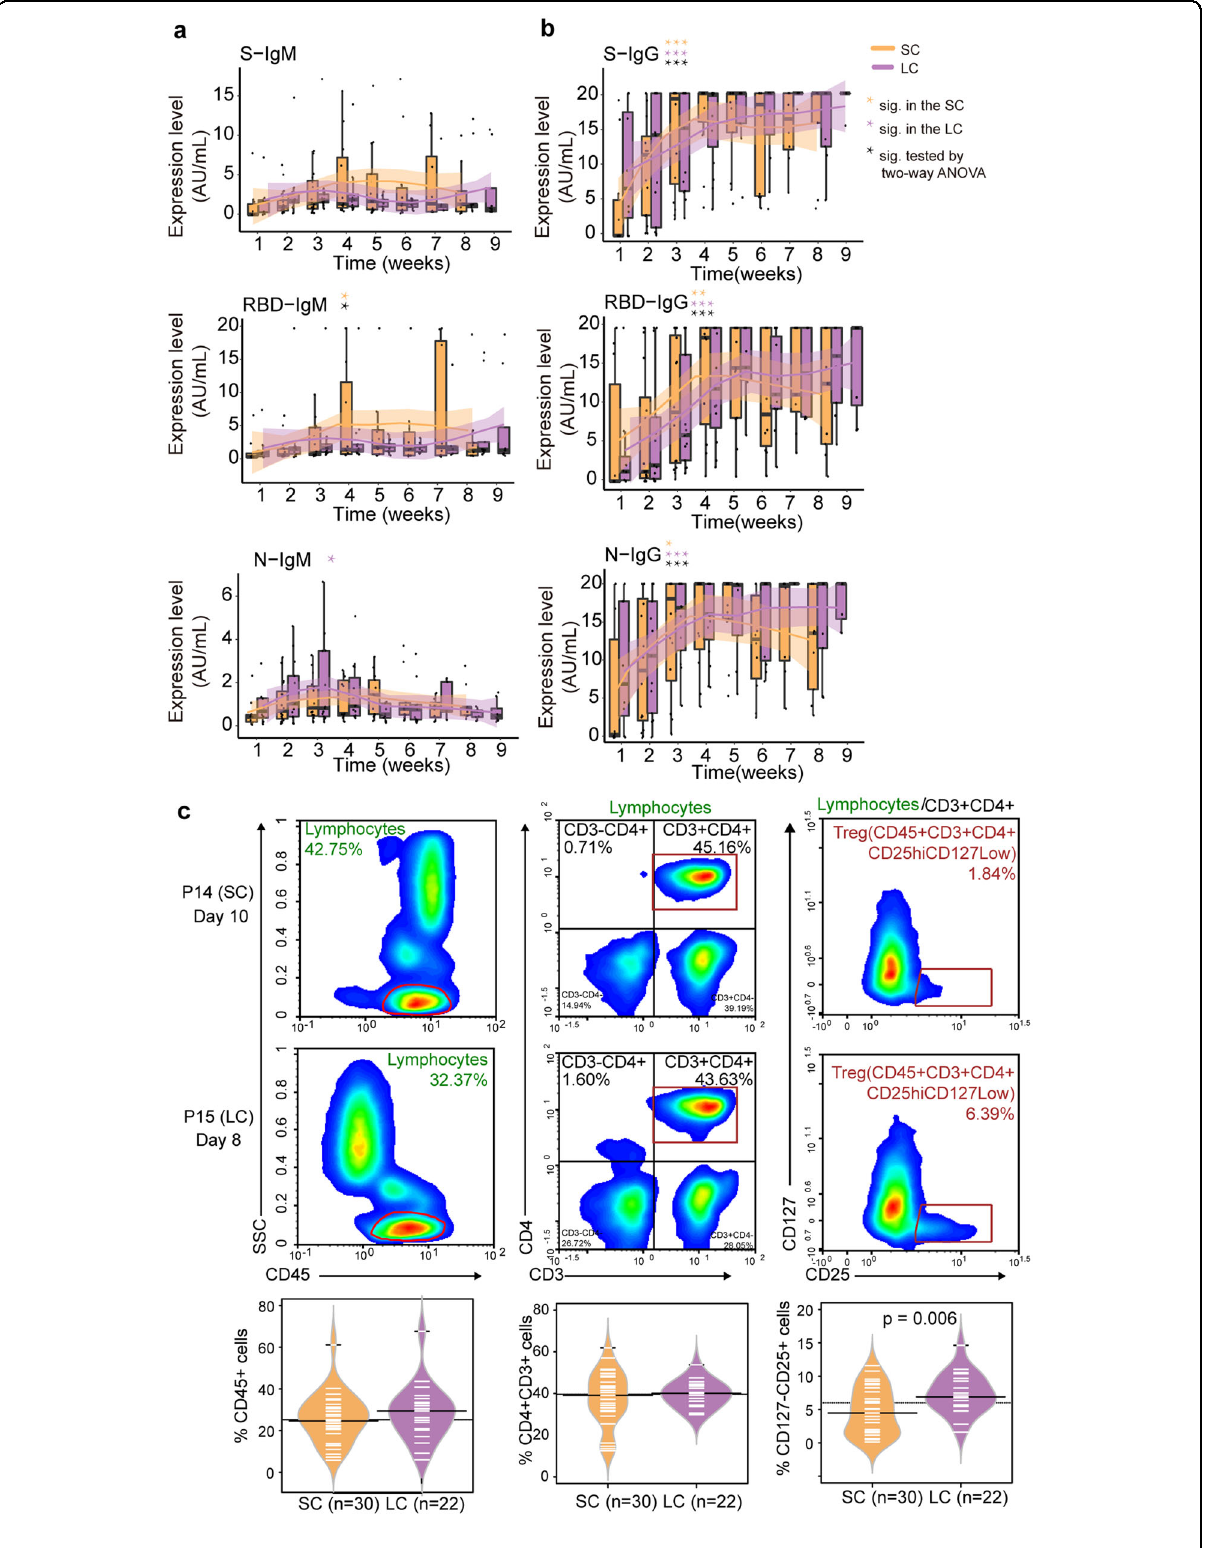
Fig. 2 (See legend on next